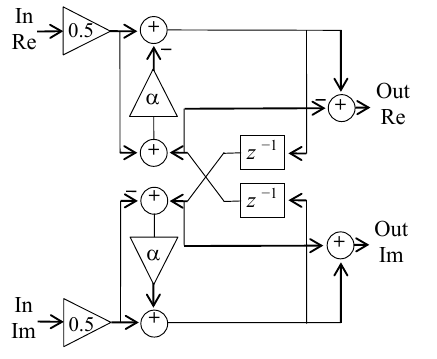
Fig. 4. Bilinear orthogonal complex MHNS-based filter [25].